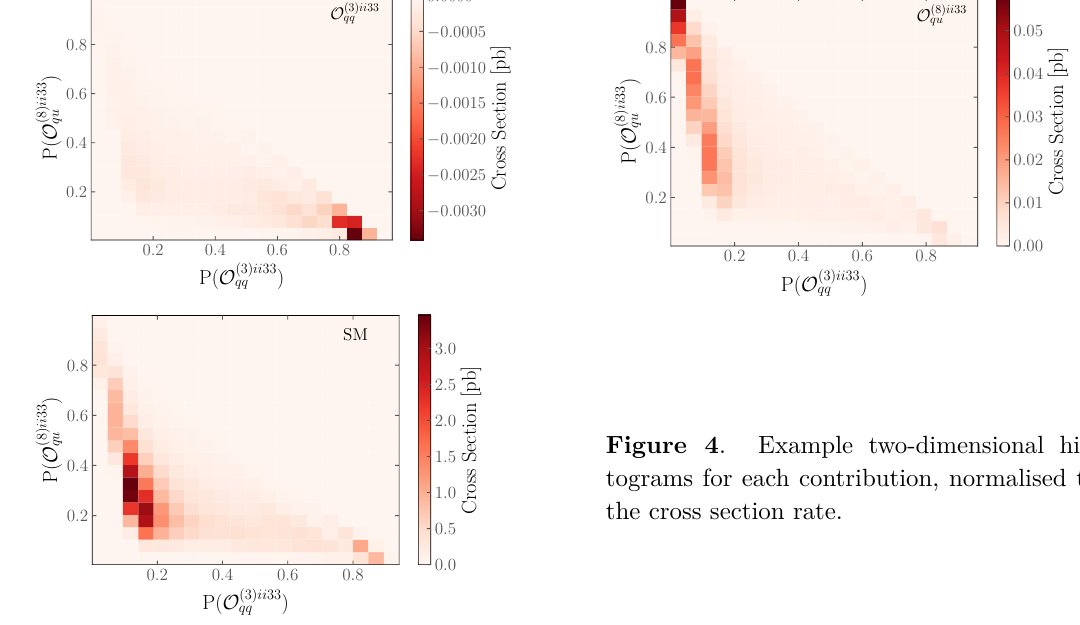
and O 3( ii 33) qq are both low (and